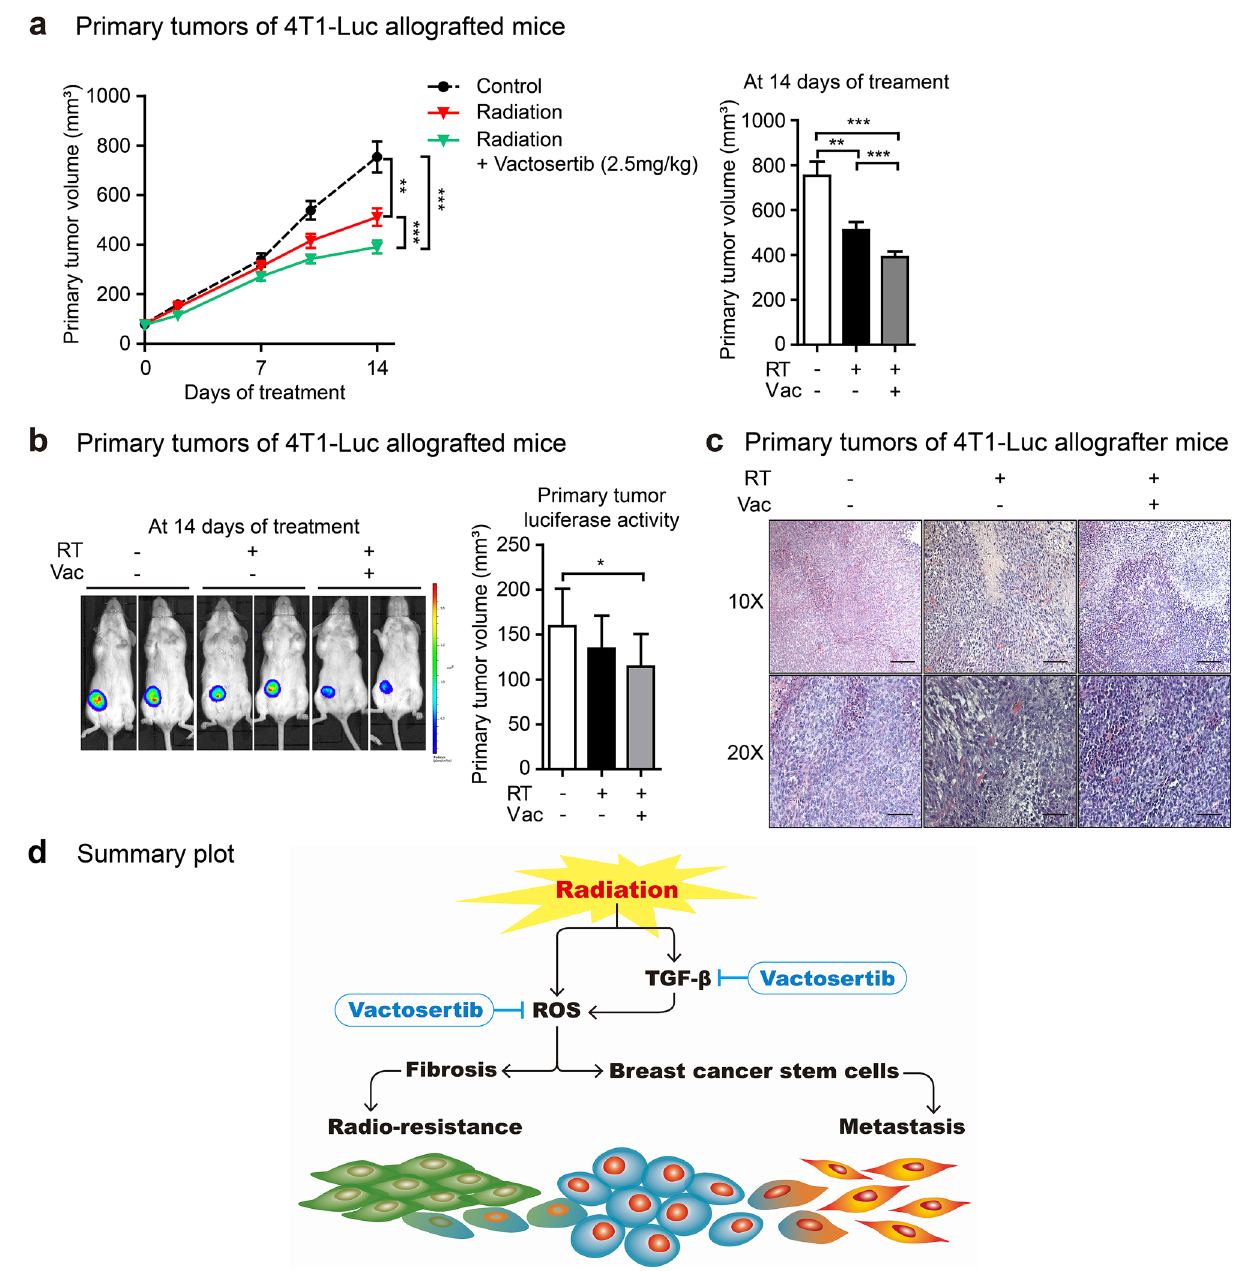
Figure 6. Vactosertib combination with radiotherapy ameliorates the tumor volume in a mouse model of breast cancer. ( a ) Treatment effect of vactosertib on primary tumor volume. The primary tumor volume was calculated after two weeks of treatment using the formula: volume (mm 3 ) = (length (mm)) × (width (mm)) 2 × 0.5 (n = 8/ group). Mice in the control group received no treatment, mice in the radiation group were irradiated with 4 Gy/ day over their whole body for three days, and mice in the radiation + vactosertib group were treated vactosertib 2.5 mg/kg p.o. for two weeks and were concurrently irradiated with 4 Gy/day over their whole body for three days. ( b ) Vactosertib reduces tumor volume in irradiated BALB/c breast cancer mice. The volume of the breast tumor was measured by bioluminescence analysis. Images show the volume of representative mouse mammary tumors in each group. ( c ) H&E staining in primary tumors of mice are displayed as images showing changes in the morphology and size of tumor cells via phase-contrast microscopy (× 10 and 20, scale bar: 100 and 50 μm). ( d ) Summary plot of radiation-induced fibrosis and breast cancer stem cells. Irradiation induces transforming growth factor-β (TGF-β) and oxidative stress in breast cancer. An ALK5 inhibitor, vactosertib, suppresses TGF-β-induced fibrosis and breast cancer stem cells by inhibiting oxidative stress generated by both TGF-β- dependent and -non-dependent pathways. Vactosertib can reduce radio-resistance and metastasis in breast cancer